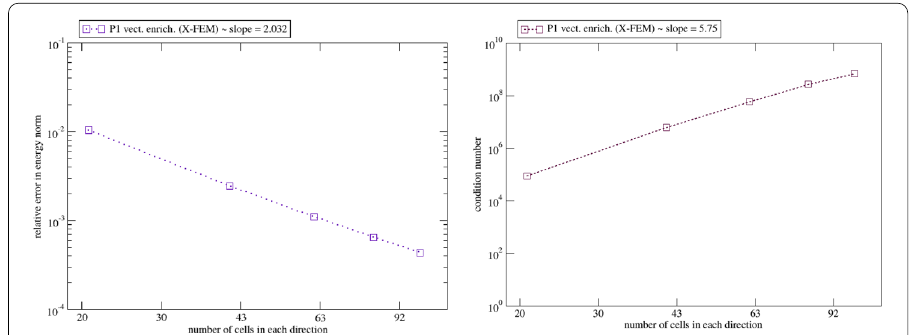
Fig. 27 Numerical behavior of the X-FEM vectorial enrichment with quadratic elements vergence rates can only be achieved if the discontinuous approximation space is of the same order than the one of the continuous space, that is to say quadratic. The correction exposed here on the quadratic form is slightly different from the ones